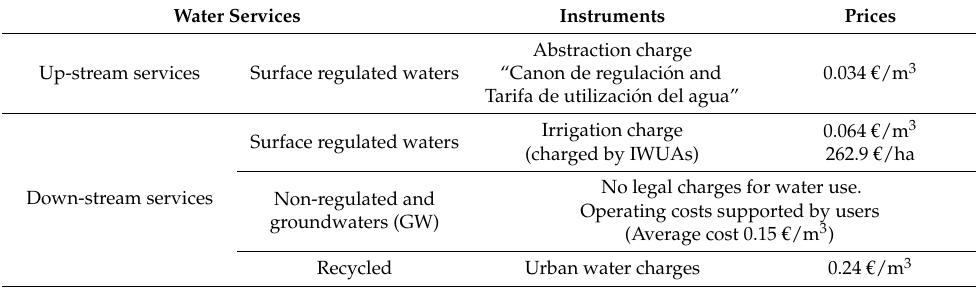
Table 4. Main CR instruments in GRB